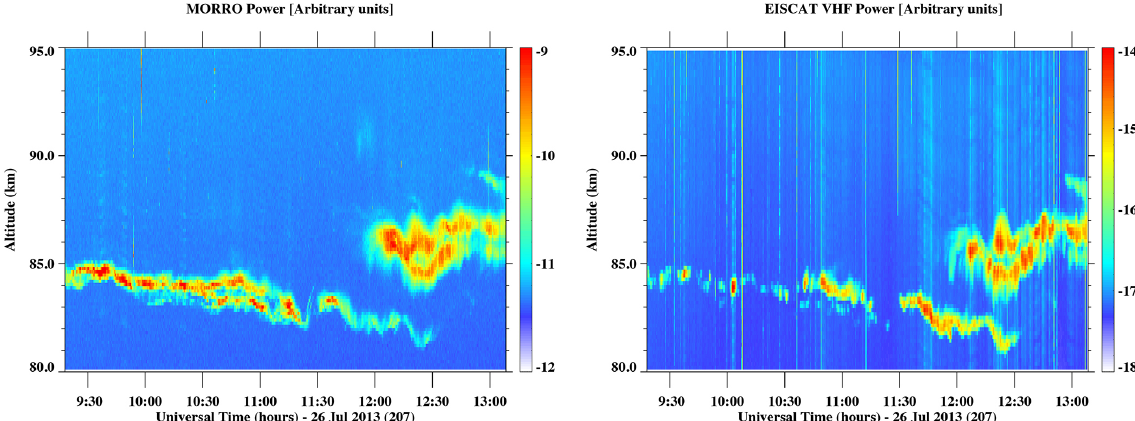
Figure 1. The overall view of the PMSEs on 26 July 2014 with the two radars MORRO at 56MHz and VHF at 224MHz. The scale is in arbitrary units.